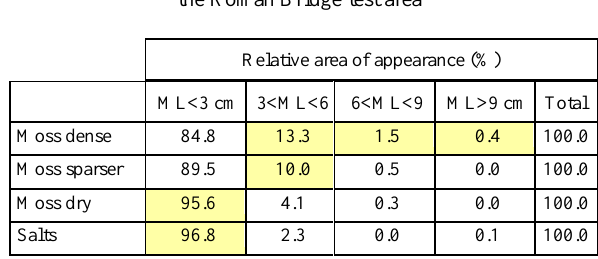
Table 5. Normalization of table 4 values based on the share of each biodeterioration type on the examined wall